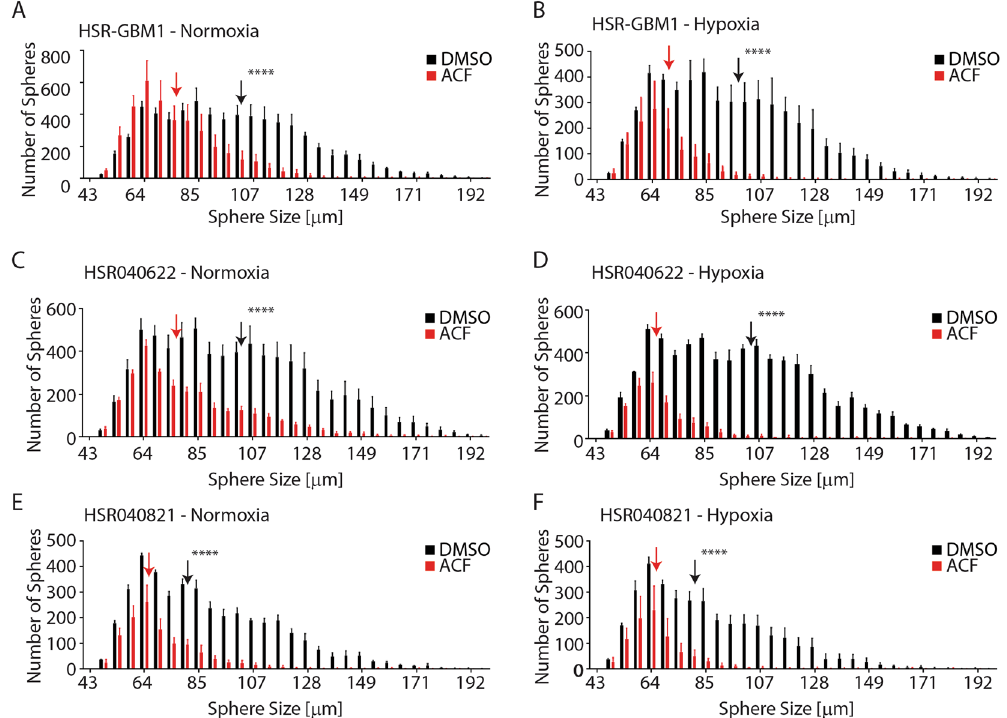
Figure 4. Clonogenic analysis in NSMC medium. HSR-GBM1 ( A , B ), HSR040622 ( C , D ), and HSR040821 (EF) were treated for 72 hours with ACF (5 μ M) or vehicle (DMSO) in normoxia ( A , C , E ) or hypoxia ( B , D , F ). Following 24 hours of recovery (in normoxia and without drug), cells were plated in NSMC medium. The clonogenic potential of ACF-treated GSCs was significantly lower as compared with vehicle in each of three GSC lines. ( **** p < 0.0001, One way ANOVA with multiple